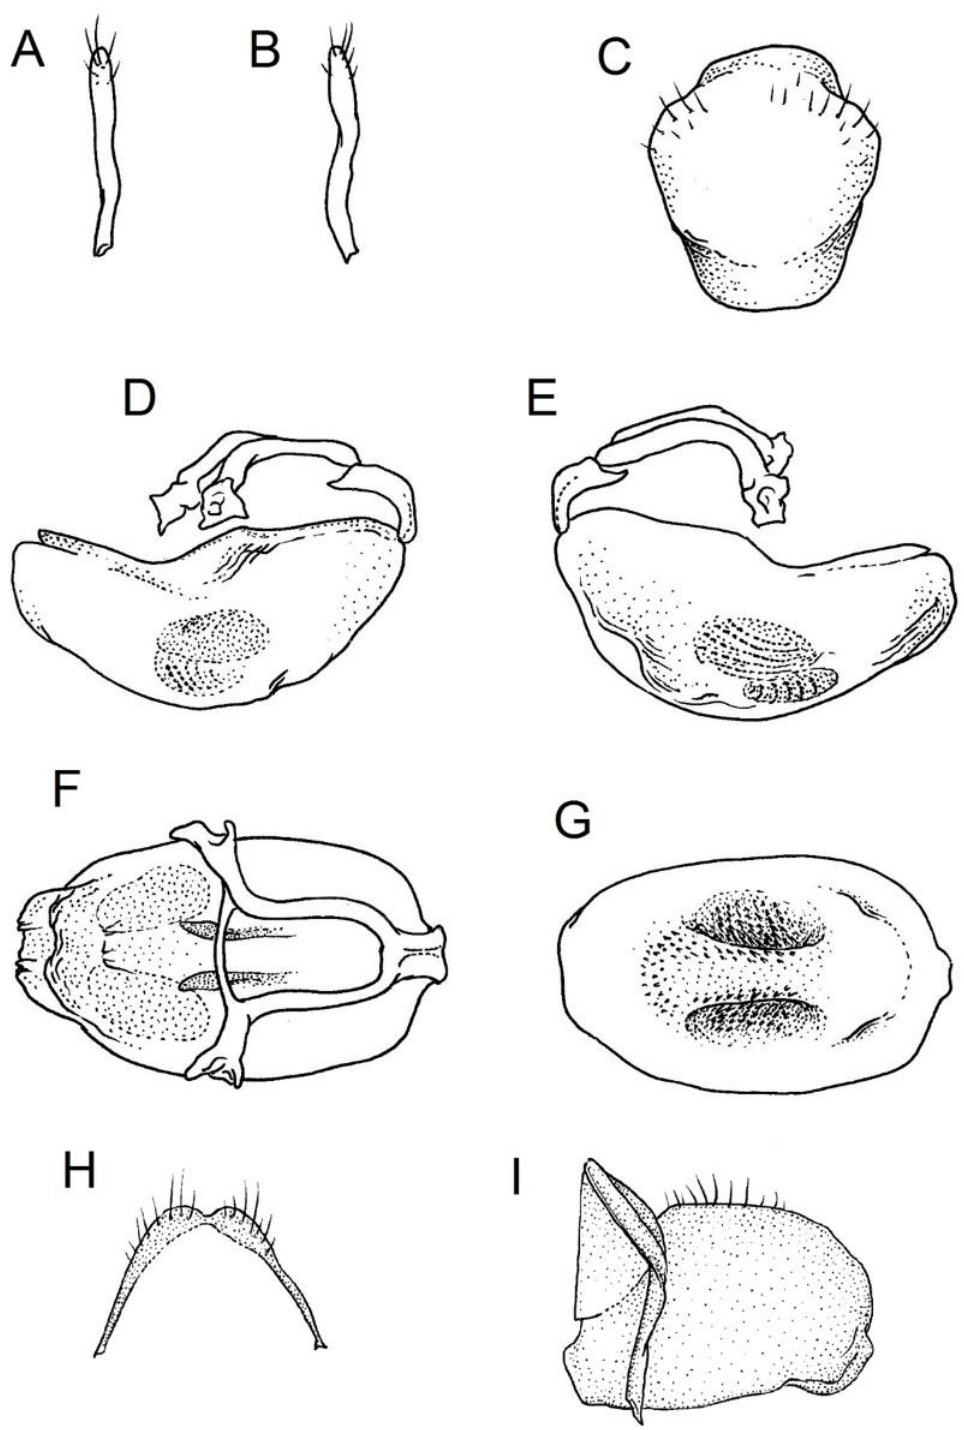
Figure 32. Phonoctonus bifasciatus Villiers, 1948: ( A ) left paramere; ( B ) right paramere; ( C ) pygophore, ventral view; ( D ) aedeagus, right lateral view; ( E ) aedeagus, left lateral view; ( F ) aedeagus, dorsal view; ( G ) aedeagus, ventral view; ( H ) styloids, outer view; and ( I ) gonocoxite of abdominal segment VIII. Abdomen : Ventrally yellow with a regular, reddish, transversal stripe on each abdom- inal segment (stripe reaching lateral margins of the segment and extended on connexiva). Each stripe is darker in the lateral portion (almost black), but the dark portion is not elongated on the abdominal stigmata area (Figure